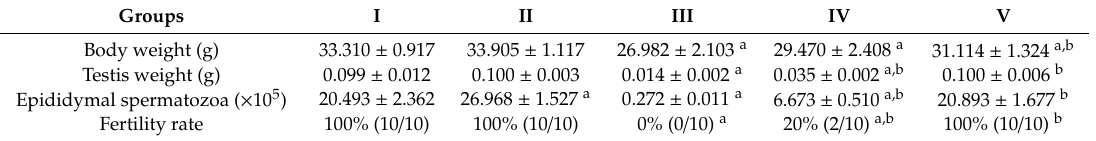
Table 2. Testicular weights and epididymal spermatozoa count in each group at day 120.